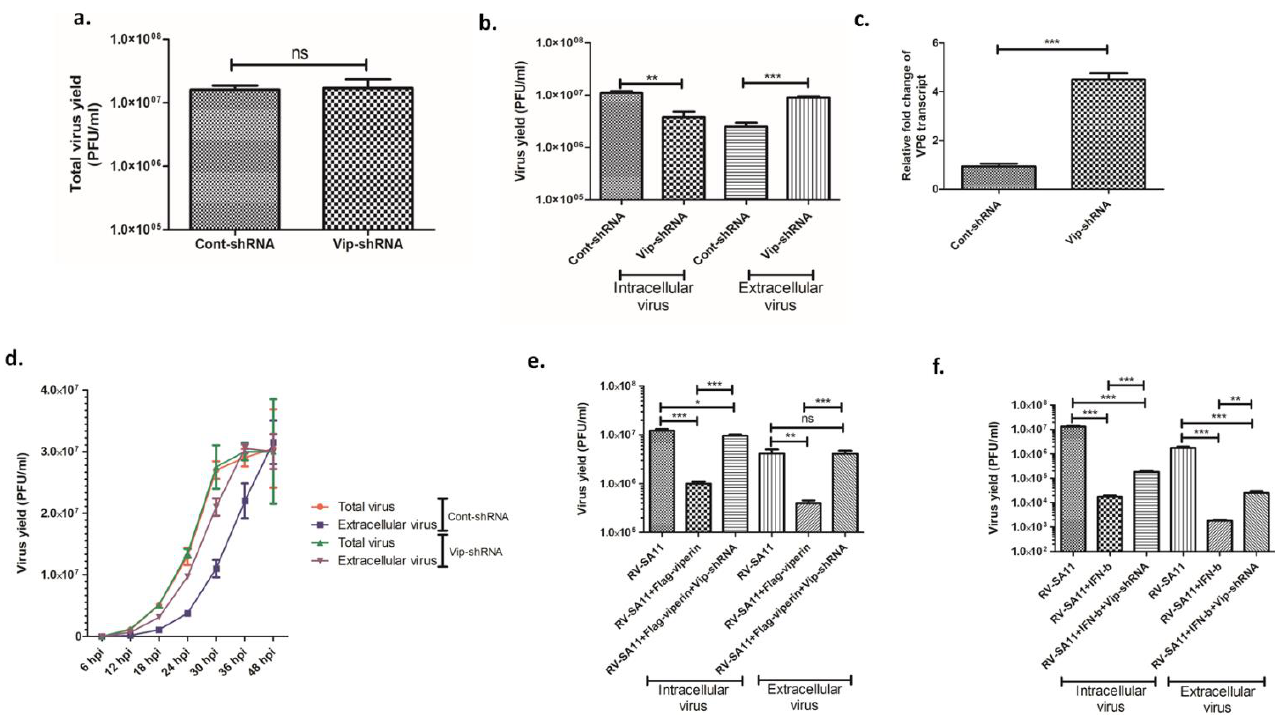
Figure 2. RV release was facilitated in viperin-knocked-down cells ( a ) HT-29 cells, pre-transfected with either cont-shRNA or vip-shRNA, were infected with RV-SA11 (MOI 3) and incubated for 24 hpi. Next, cells were collected along with extracellular medium, freeze – thawed three times, centrifuged and subjected to plaque assay to measure viral titer. Data represent mean virus particles ± SD of three independent experiments (ns: not significant, unpaired S tudent’s t -test). ( b ) HT-29 cells, pre-transfected with either cont-shRNA or vip-shRNA, were infected with RV-SA11 (MOI 3) for 24 hpi. After incubation, extracellular medium was collected and used to quantify released viral particles by plaque assay whereas infected cells were collected in fresh medium, freeze – thawed three times, centrifuged and subjected to plaque assay to measure intracellular viral titer. Data represent mean virus particles ± SD of three independent experiments; *** represents p ≤ 0.001, ** represents p ≤ 0.01, unpaired S tudent’s t -test. ( c ) HT-29 cells transfected with either cont-shRNA or vip-shRNA were infected with RV-SA11 at an MOI of 3 and incubated for 24 h. After incubation, extracellular medium was collected, clarified and treated with RNAse. Next, RNA was isolated from the medium and used to quantify the level of VP6 RNA by real-time PCR. Data represent mean fold change ± SD of three independent experiments; *** represents p ≤ 0.001, unpaired S tudent’s t -test. ( d ) HT-29 cells, pre-transfected with either cont-shRNA or vip-shRNA, were infected with RV-SA11 (MOI 3) and incubated until the indicated time points. After incubation, both the total infectious viral titer and released viral titer were measured by plaque assay. Data represent mean viral titer ± SD of three independent ex- periments. ( e ) RV-SA11-infected Vero cells, transfected with cont-vector and cont-shRNA, FLAG-viperin and cont-shRNA or FLAG-viperin and vip-shRNA, were used to measure both the intracellular and extracellular viral parti- cles by plaque assay. Data represent mean viral particles ± SD of three independent experiments; *** represents p ≤ 0.001, ** represents p ≤ 0.01, * represents p ≤ 0.05, ns represents p value non-significant, unpaired S tudent’s t -test. ( f ) HT-29 cells, transfected with either cont-shRNA or vip-shRNA, were treated with IFN- β for 2 h followed by infection with RV -SA11 at an MOI of 3 for 24 hpi. Next, intracellular and extracellular viruses were collected and subjected to plaque assay. Data represent mean virus particles ± SD of three independent experiments; *** represents p ≤ 0.001, ** represents p ≤ 0.01, unpaired S tudent’s t -test.